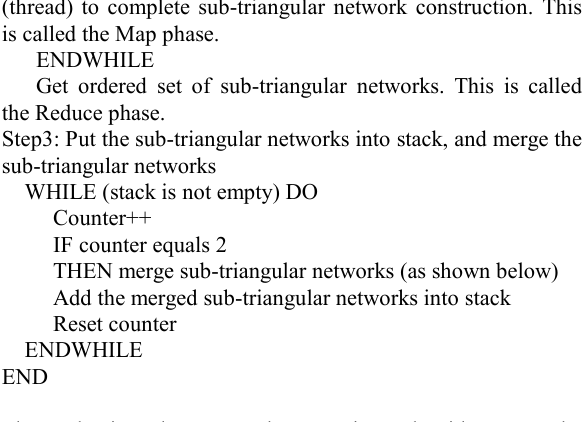
(d) Zoomed-in of the area A in